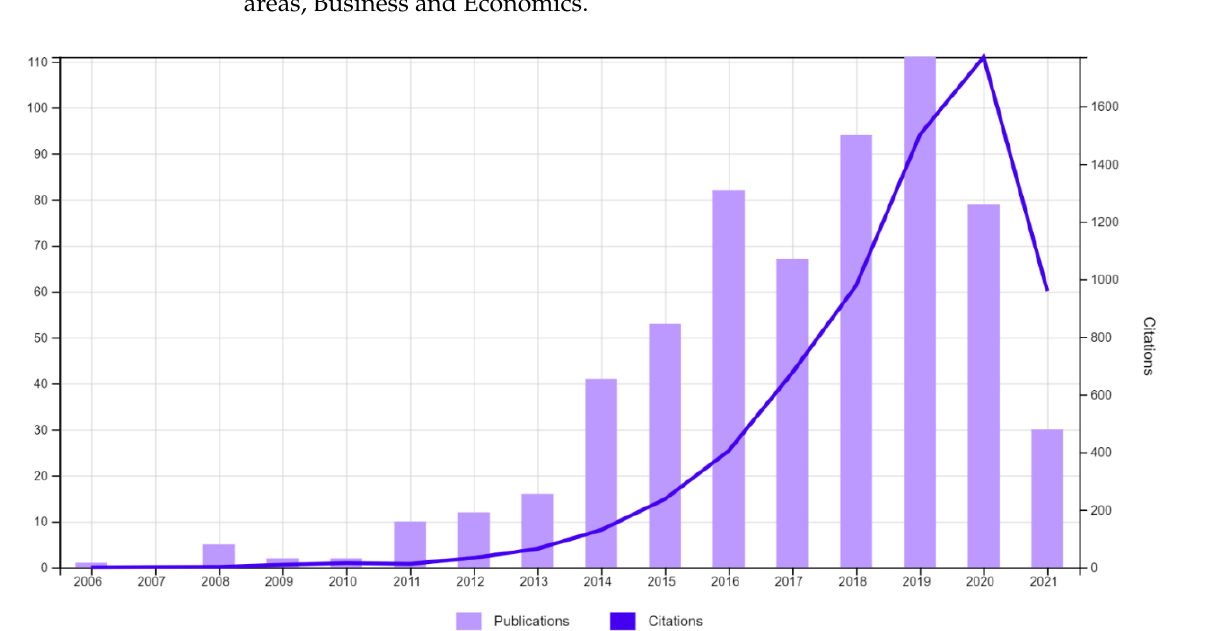
Figure 2. Times cited and publications over time. Source: Web of Science.